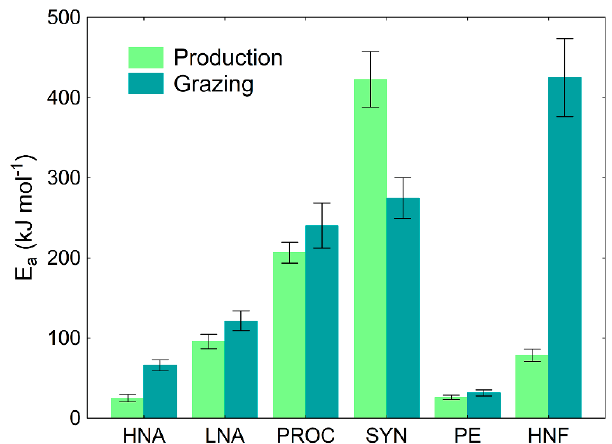
Figure 2. Apparent activation energy (E a ) as mean ± standard deviation (SD) was derived from the regression slope of the Arrhenius plots for production and losses-to-grazing of the studied microbial groups. HNA, high nucleic-acid bacteria; LNA, low nucleic-acid bacteria; PROC, Prochlorococcus ; SYN, Synechococcus ; PE, picoeukaryotes; HNF, heterotrophic nanoflagellates). 3.3. Relative Contribution of Prey Biomass to Total biomass Ingested by Protistan Predators In general, the largest portion of picoplankton biomass ingested by HNF and CIL came from HNA (from 50% to 60%) and PE (from 20% to 30%), whereas the contribution of PROC to total ingested biomass was negligible (less than 0.1%; Figure 3). The most significant change in HNF grazing, that occurred after a 3 °C rise in temperature, was increased proportion of ingested SYN biomass (from 3% to 7%), mostly at the expense of the PE which decreased from 29% to 24% in terms of contribution in total ingested biomass Even more noticeable changes after a rise in temperature occurred in ciliate grazing pressure. The contribution of HNF and SYN in satisfying CIL carbon demand increased by 10% and 6%, respectively (Figure 3).